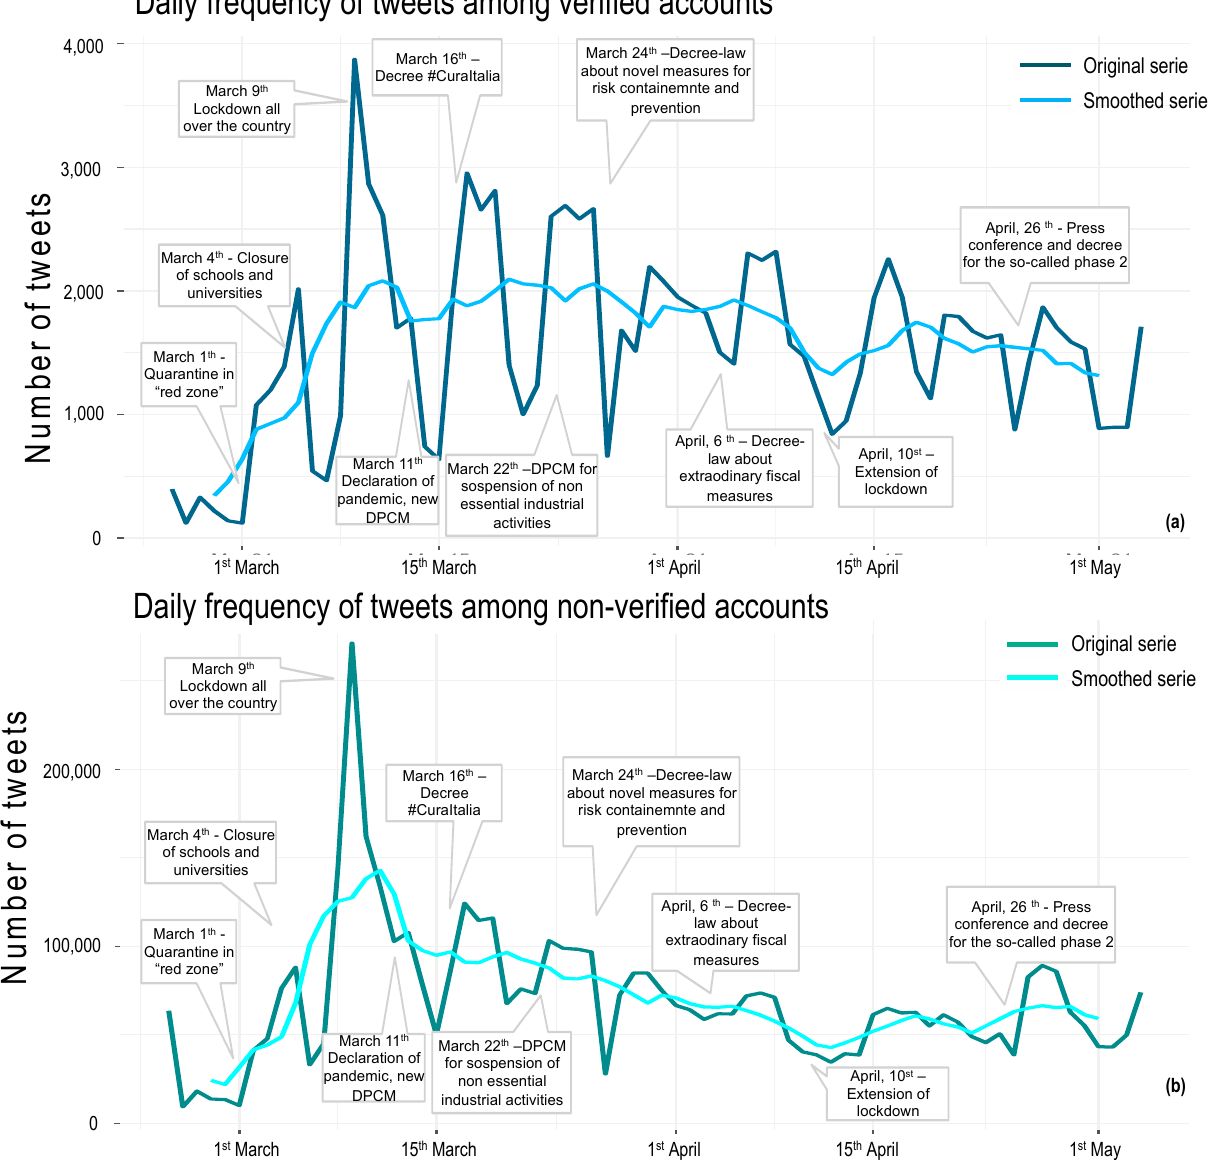
Figure 2. Daily counts of tweets. ( a ) Daily counts of tweets (and retweets) posted throughout the time frame among verified accounts. ( b ) Daily counts of tweets (and retweets) posted throughout the time frame among non-verified accounts. In all panels, national key events are highlighted, and the original time-series of row count and the smoothed series were obtained using simple moving average (MA) based on 7 days to remove peak and the “weekend effect”.